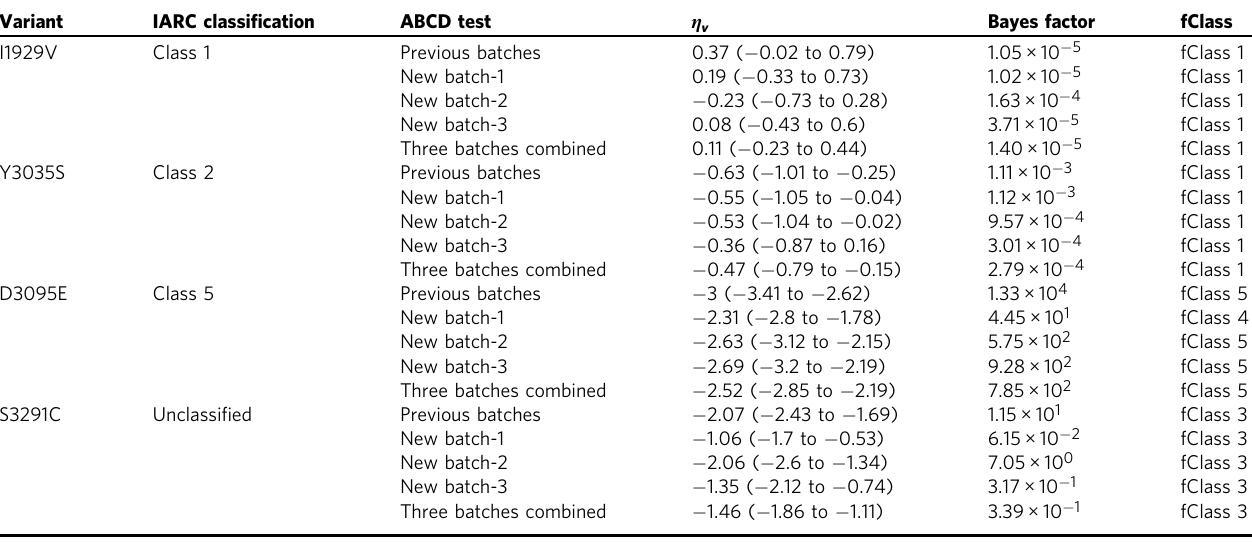
Table 1 Results of an experimental ABCD test.